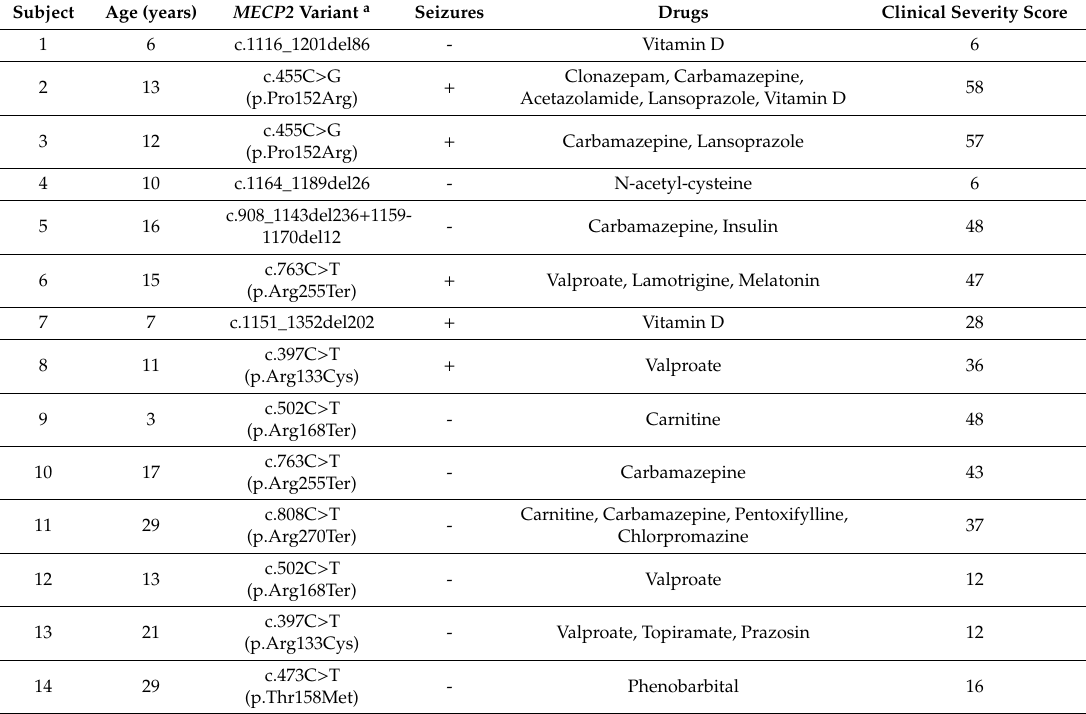
Table 1. Features of subjects included in the